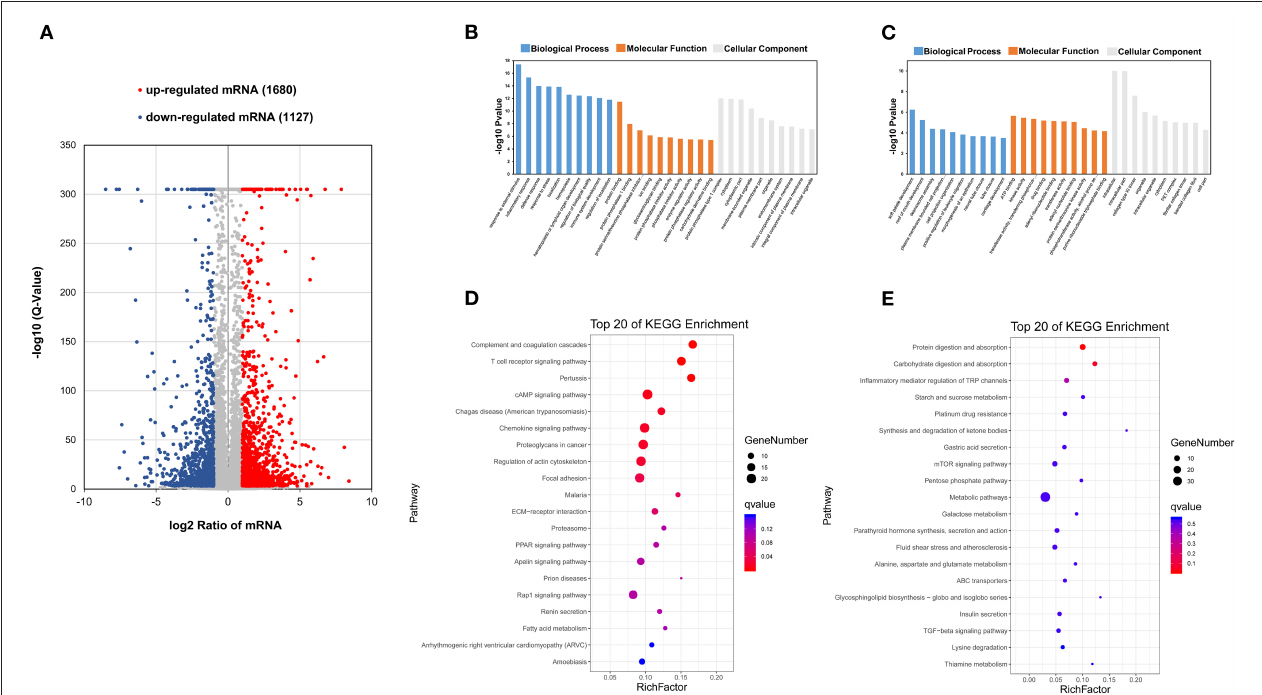
FIGURE 4 | Analyses of RNA-seq. (A) Scatter plot of transcriptome data ( q < 0.001, |log 2 (fold change)| ≥ 1). (B) GO enrichment analysis of upregulated mRNAs. (C) GO enrichment analysis of downregulated mRNAs. (D) KEGG classification of upregulated mRNAs. (E) KEGG classification of downregulated